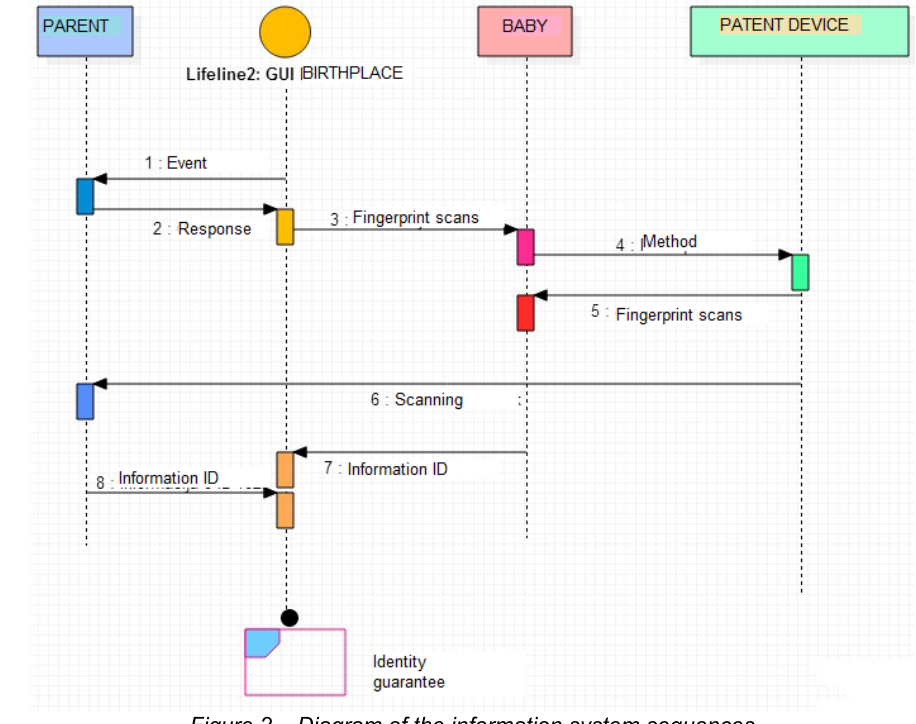
Figure 2 – Diagram of the information system sequences Рис . 2 – Диаграмма последовательностей Информационной